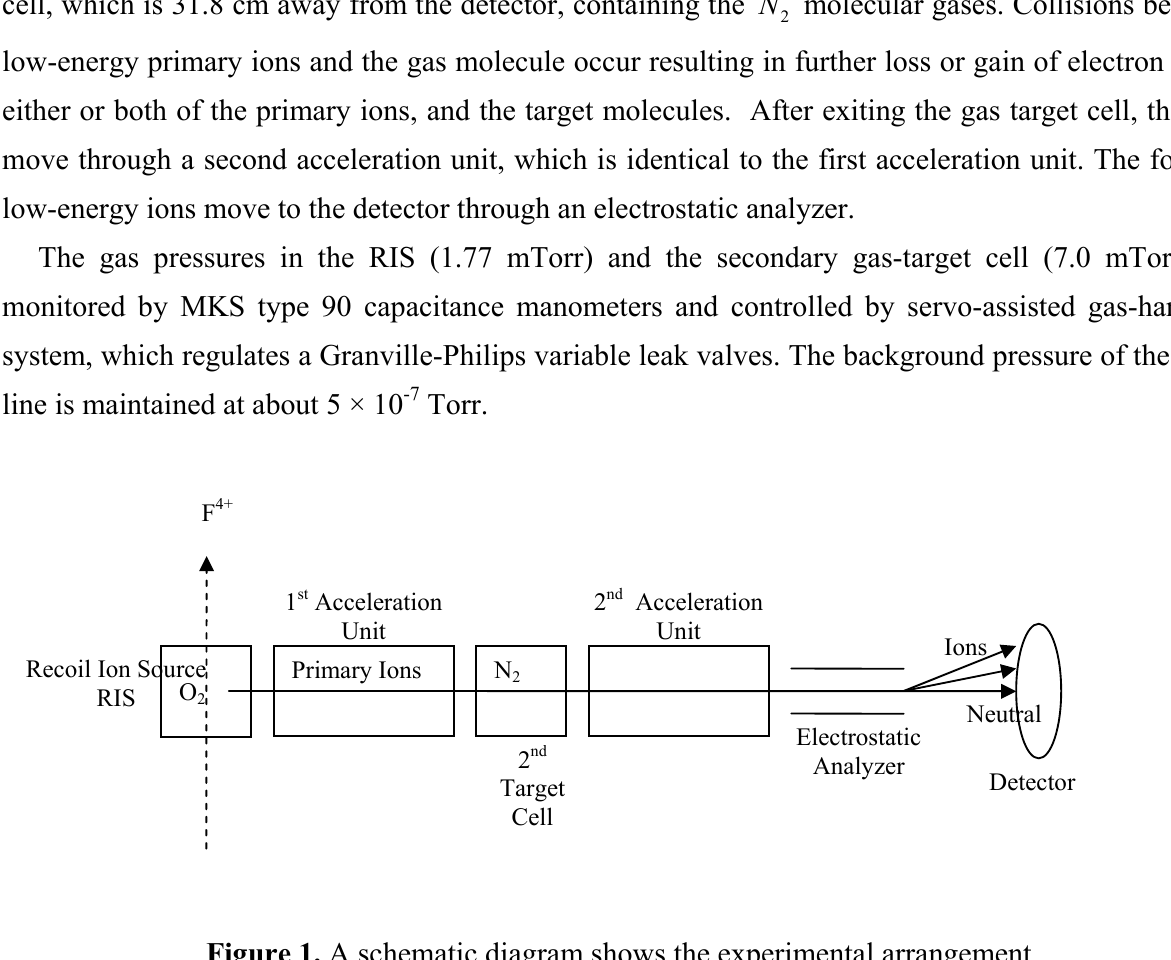
Figure 1. A schematic diagram shows the experimental